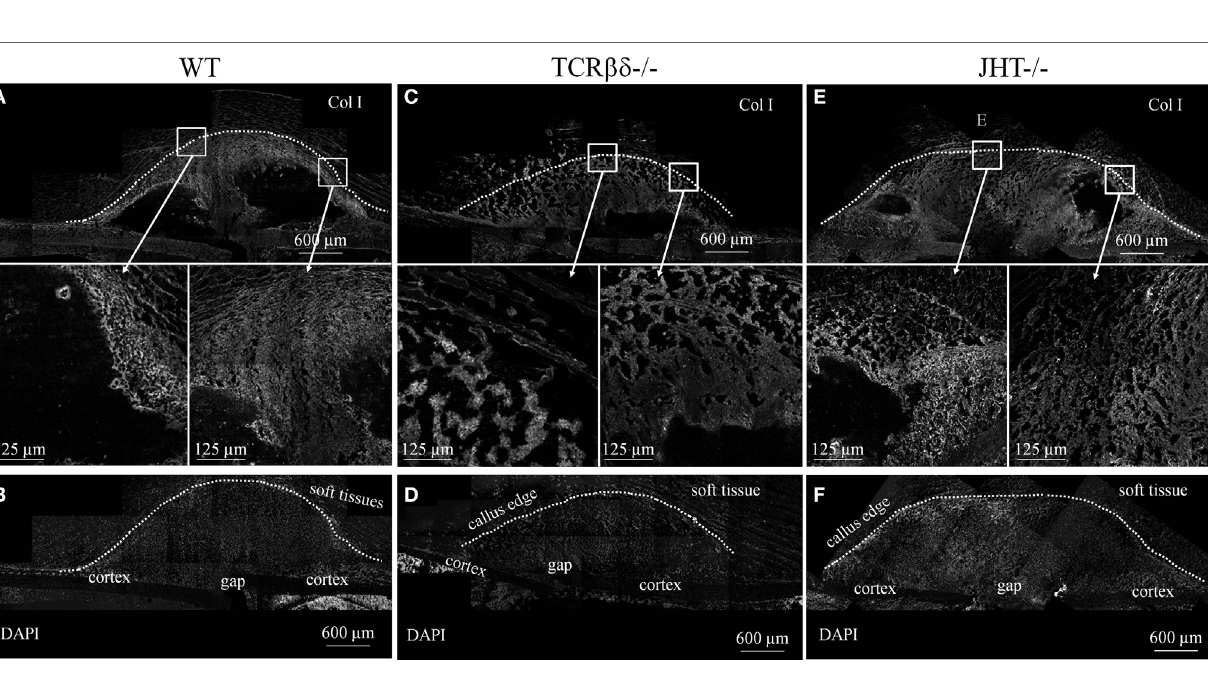
FigUre 11 | aberrant deposition of collagen type i (coli) in the soft callus of T cell-deficient mice . Confocal microscope analysis of the callus of wild-type (WT) (a,B) , T cell-deficient [T cell receptor β and δ chain homozygous knockout (TCR βδ − / − )] (c,D) and B cell-deficient [joining region homozygous knockout (JHT − / − )] (e,F) mice. Sections were stained for the ColI (gray). Areas within the white rectangles are represented below in a higher magnification. (B,D,F) show DAPI staining of cell nuclei to highlight the cellular topography corresponding to calluses displayed in (a,c,e) , respectively. Soft tissues are visible due to their strong autofluorescence. All sections were taken 7 days after